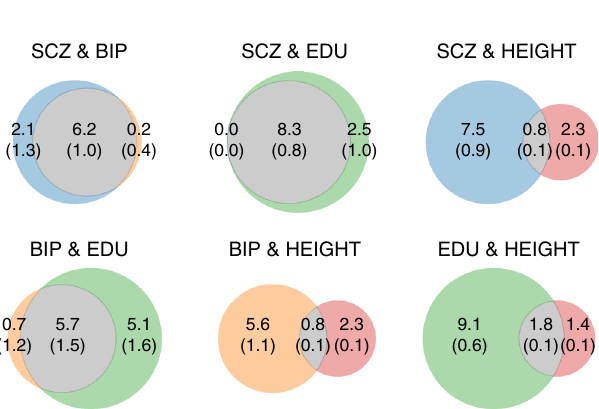
Fig. 3 Venn diagrams of unique and shared polygenic components at the causal level, showing polygenic overlap (gray) between schizophrenia (SCZ, blue), bipolar disorder (BIP, orange), educational attainment (EDU, green), and height (red). The numbers indicate the estimated quantity of causal variants (in thousands) per component, explaining 90% of SNP heritability in each phenotype, followed by the standard error. The size of the circles re fl ects the degree of